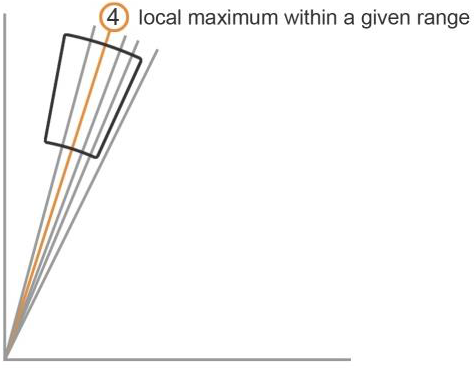
10 of 25 Figure 3. Calculation of intersection points on the orthogonal grid derived from original points. Tolerance in horizontal and vertical positioning: The list of all possible intersection points is recalculated to assign the same x-value to all x-values whose difference is within a previously given range. This method is then applied also to all y-values in the same manner. Centered Calculation of Local Maxima: Previous versions of the gradient analysis calculated local maxima in a top down fashion, starting with the 90 degree gradient and